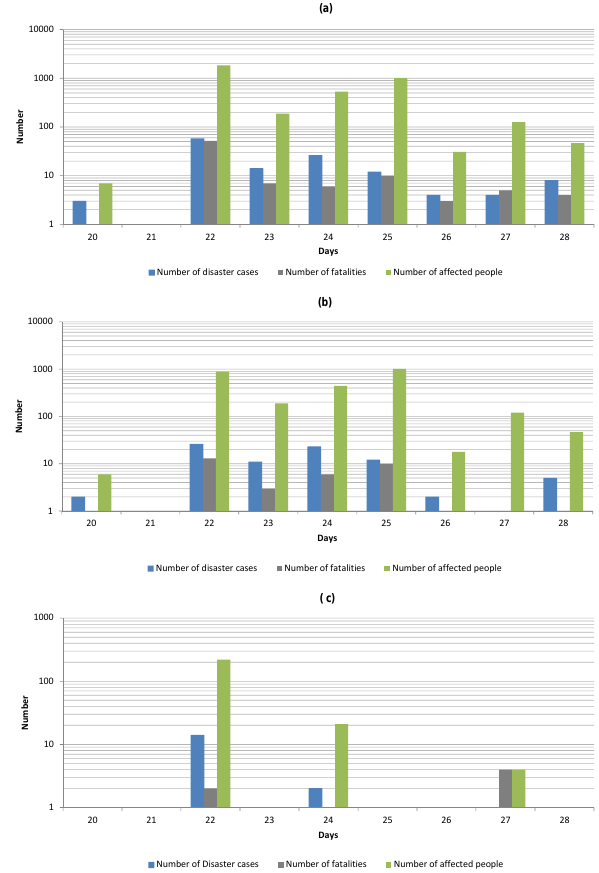
Figure 6. Daily number of DISASTER cases, fatalities, and affected people generated by the December 1909 event (a) , in the Douro Basin (b) , and in the Tagus Basin (c) . Notice the logarithmic scale